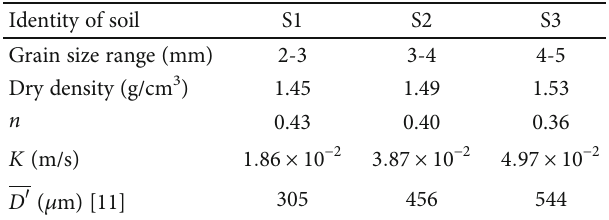
Table 1: Basic physical indexes of the test